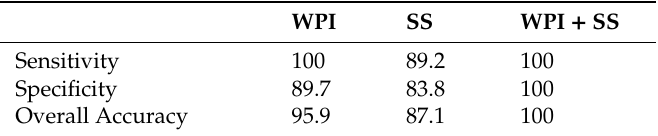
Table 6. Sensitivity, specificity and overall accuracy (%) for the discrimination between FMS and RA patients for Widespread Pain Index (WPI) and Symptom Severity (SS)